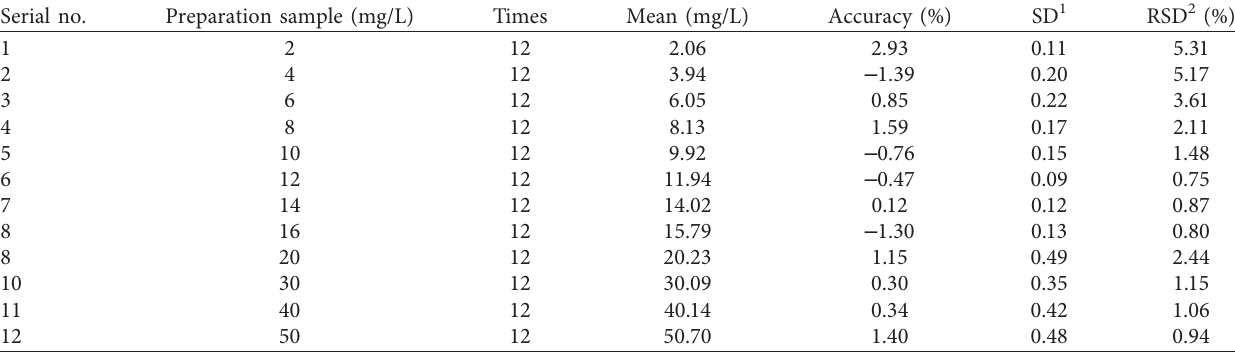
Figure 7: (a) Optimization of heating temperature. (b) Optimization of heating time. Table 4: The results of accuracy and